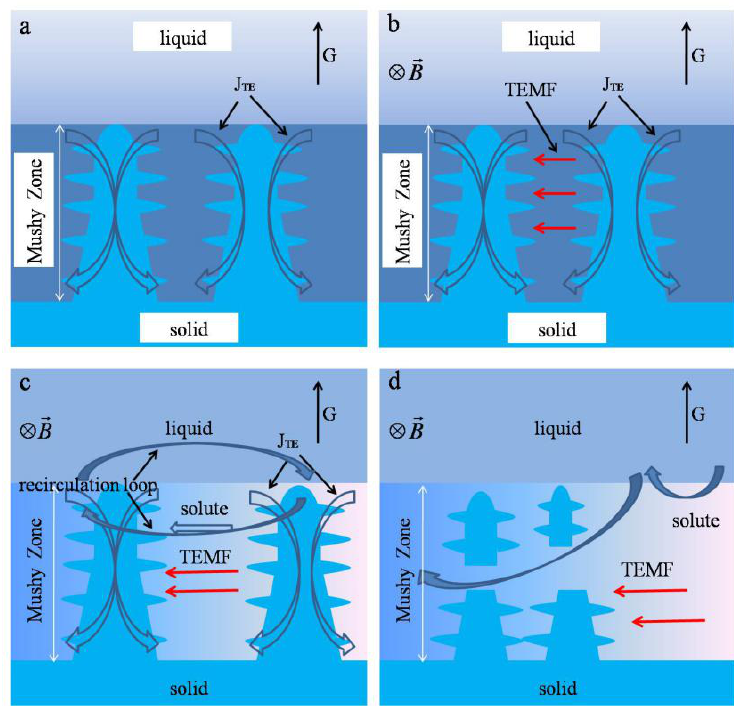
Figure 9. Schematic illustration of thermoelectric magnetic convection of transverse magnetic field. ( a ) Schematic views of TE effects during directional solidification under a magnetic field; ( b ) Schematic views of thermoelectric magnetic force; ( c ) recirculation loop induced by TEMC; ( d ) macro-segregation